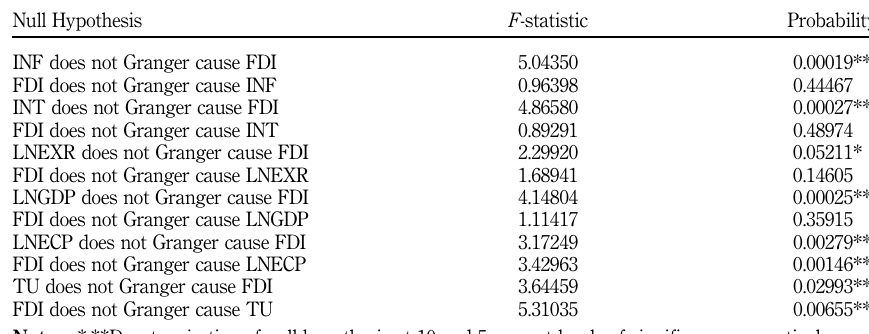
Null Hypothesis F -statistic Probability INF does not Granger cause FDI 5.04350